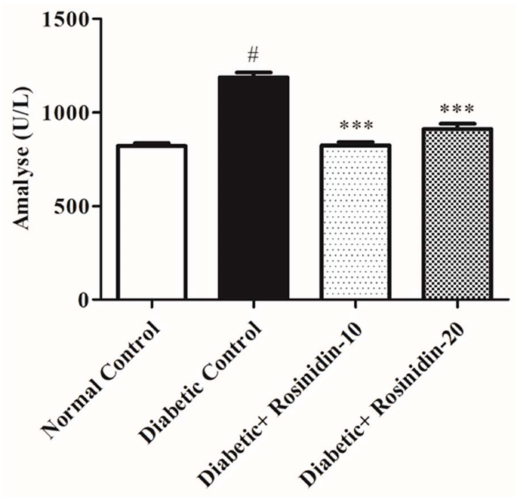
Figure 11. Effect of rosinidin on α -amylase against that of STZ-induced diabetic rats ( n = 6). Values are expressed as mean ± SEM. # p < 0.05, normal control vs. diabetic control; *** p < 0.001, diabetic control vs. rosinidin-10, rosinidin-20.